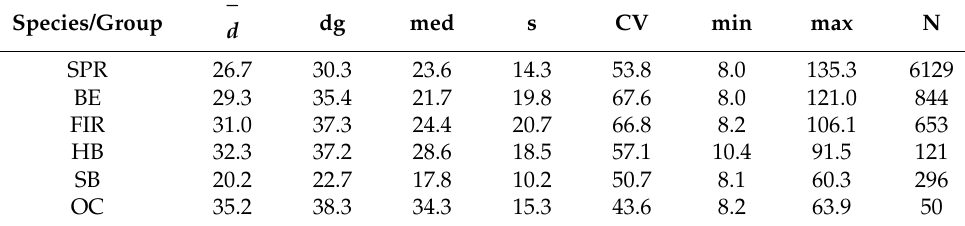
Table 2. Species main biometric characteristics of the fitting dataset.